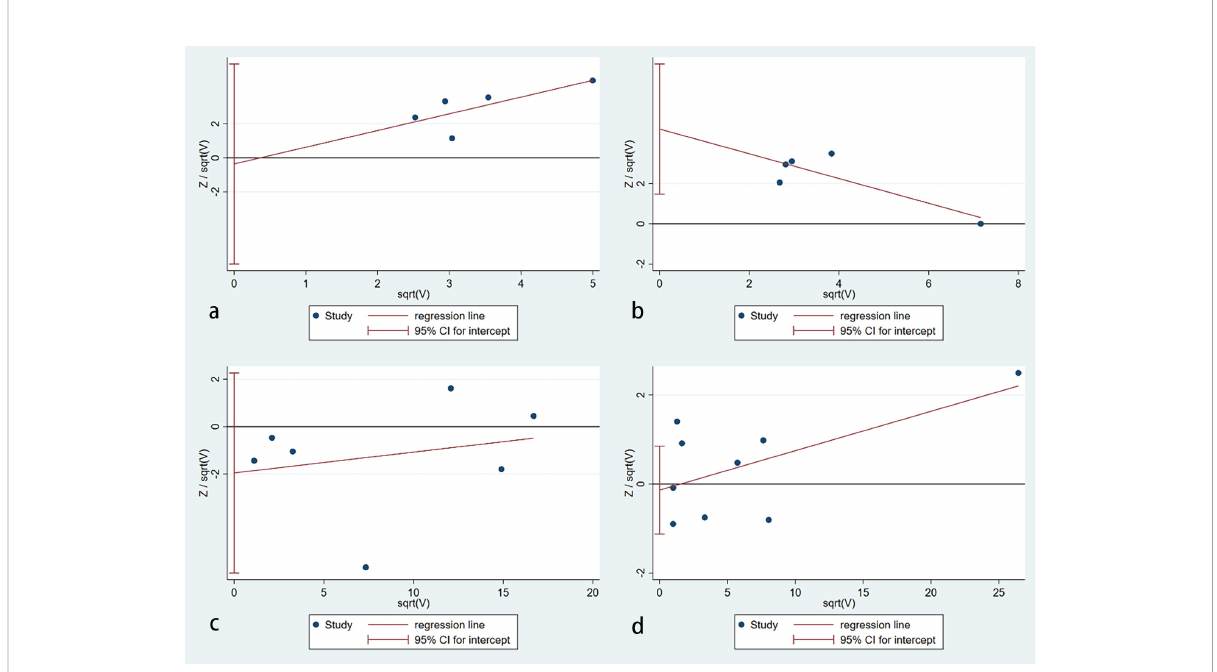
FIGURE 5 Publication bias assessment. (A) an autoimmune thyroiditis; (B) goiter; (C) hypothyroidism; (D) hyperthyroidism (no publication bias was found in autoimmune thyroiditis (p=0.857), hypothyroidism (p=0.287) and hyperthyroidism (p=0.754) subgroups. However, publication bias existed in the goiter subgroup with a p-value of